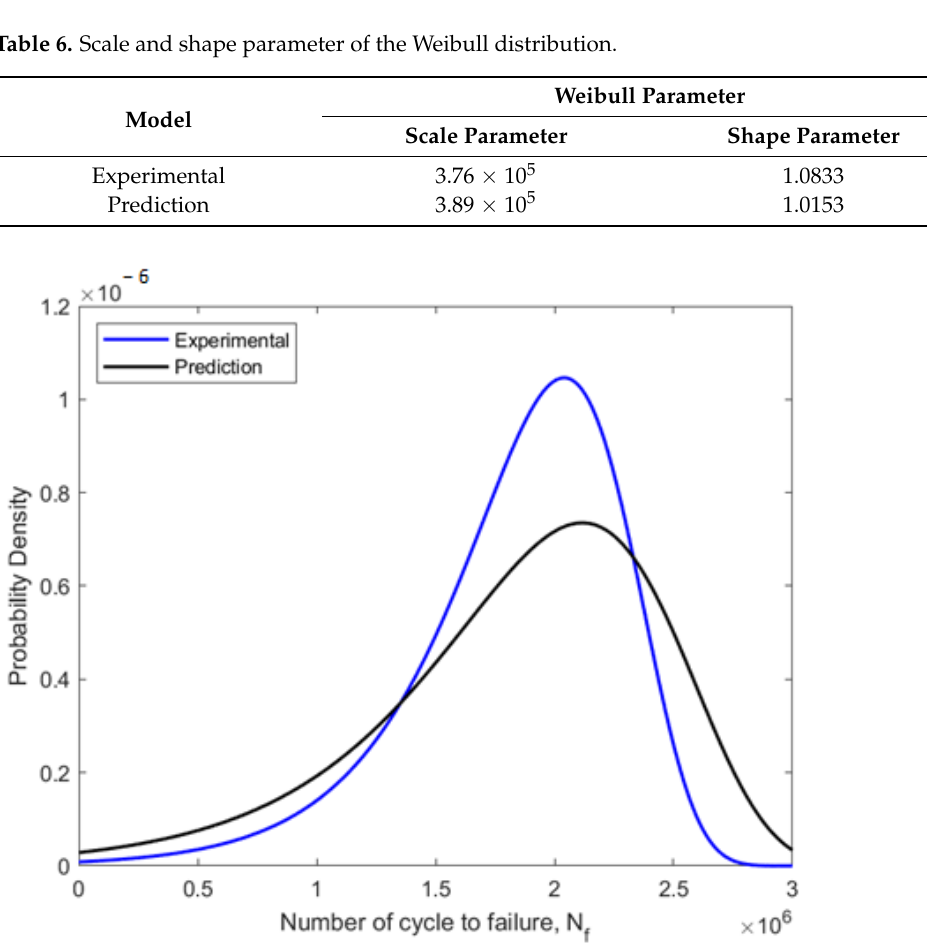
Figure 14. Weibull distribution CDF fitted using experimental and predicted data on fatigue. Table 7 depicts the MCTF of the fatigue data computed by the experimental uniaxial test and the prediction using the substitution of the dH(y)/dx parameter into the Basquin equation. The fatigue data from the experiment gave higher MCTF values than the pre- diction data, with the tiny margin being 3.37 × 10 5 cycles and 3.28 × 10 5 cycles. This clearly indicated that the dH(y)/dx parameter can be applied in the Basquin equation to estimate fatigue life through the equivalence of localised stress parameters. The Weibull probabil- ity curve was fitted with the fatigue data arising from the use of several durability models in this work to determine the utility of fitting the dH(y)/dx parameter adaptation into the Basquin equation to estimate fatigue life. Table 7. MCTF of fatigue data obtained by experiment and prediction. Obtained Fatigue Life